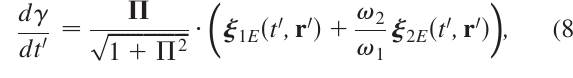
p ffiffiffiffiffiffiffiffiffiffiffiffiffiffiffiffi 1 þ (cid:1) 2 is the Lorentz